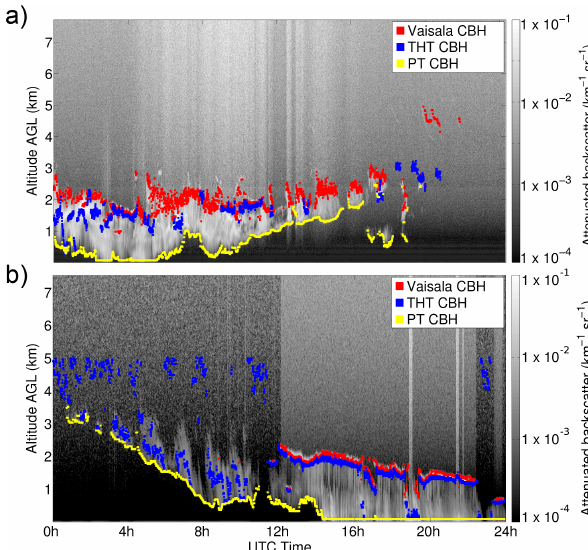
Fig. 7. Comparison of CBH detection results from Vaisala (red), THT (blue) and PT (yellow) algorithms for (a) PE ceilometer case of 14 March 2011 and (b) Summit ceilometer case of 19 Decem- ber